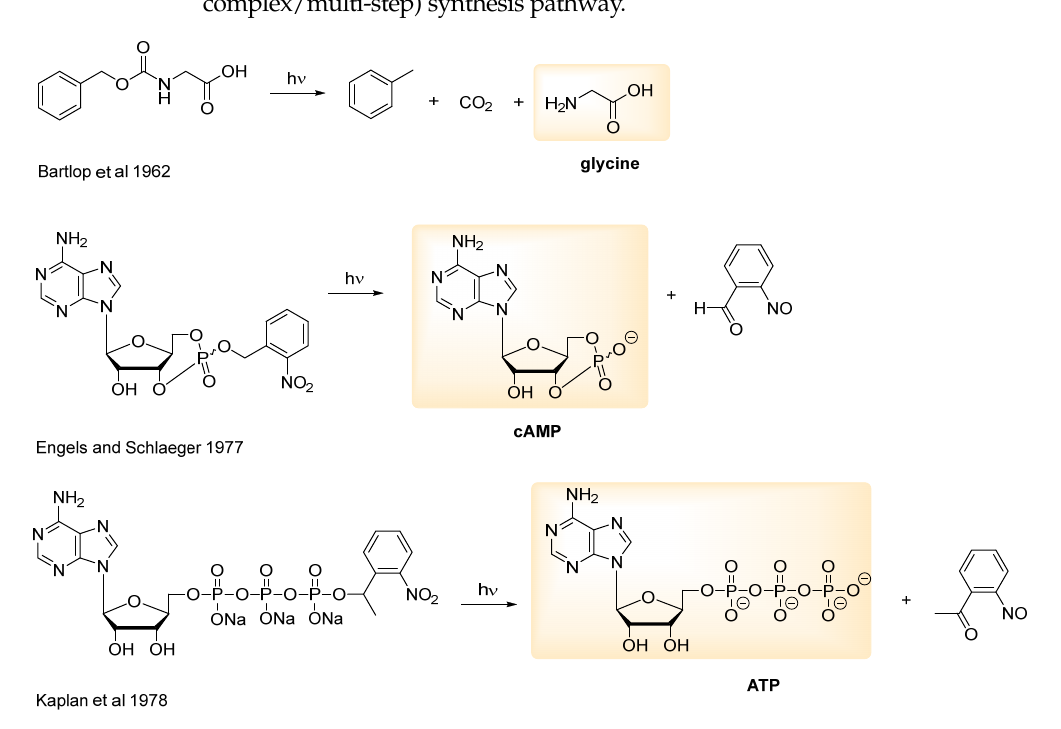
Figure 2. First applications of PPGs for biologically active substrates: glycine [12], cAMP [10] and ATP [11].